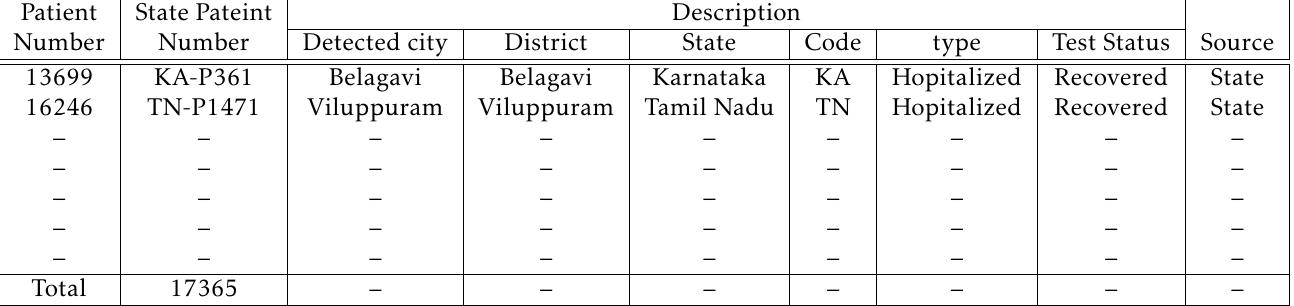
Total Table 6. Example of joining updated rows of input files (raw_data1, raw_data2, raw_data3) to procduce output file Patient State Pateint